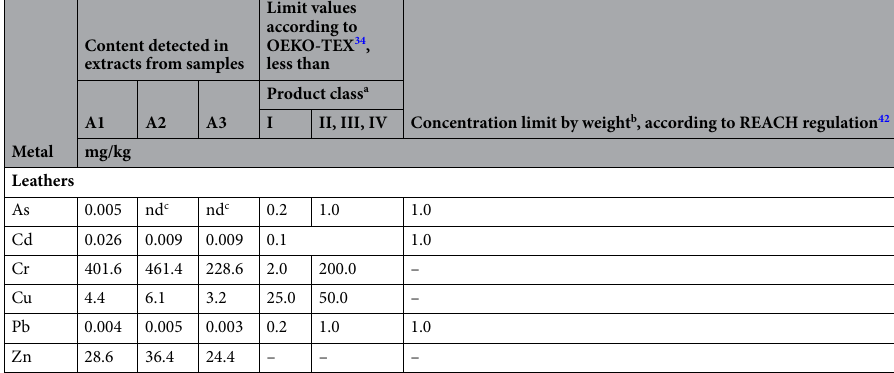
Table 2. As, Cd, Cr, Cu, Pb and Zn content in the extracts obtained from leathers and limits for their content according to OEKO-TEX and REACH regulation. Source: Author’s own research, limits of metal content based on the OEKO-TEX 34 —Annex IV and REACH Regulation 42 —Appendix 12. a I—products for infants and young children up to 36 months of age, II—products in direct contact with the skin, III—products in no direct contact with the skin, IV—decorative products; b after extraction, expressed as As, Cd and Pb metal respectively, that can be extracted from the material; c not detected.